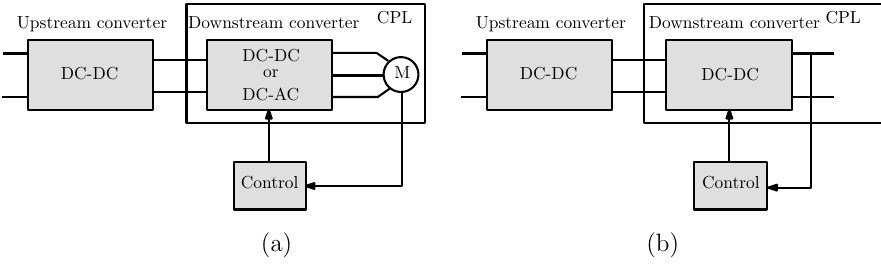
Figure 1. Power supply systems using a multiconverter approach where the CPL behavior may appear. ( a ) an Upstream converter loaded by a downstream converter regulating a DC-DC or DC-AC motor drive; ( b ) an upstream converter supplying a tightly regulated downstream